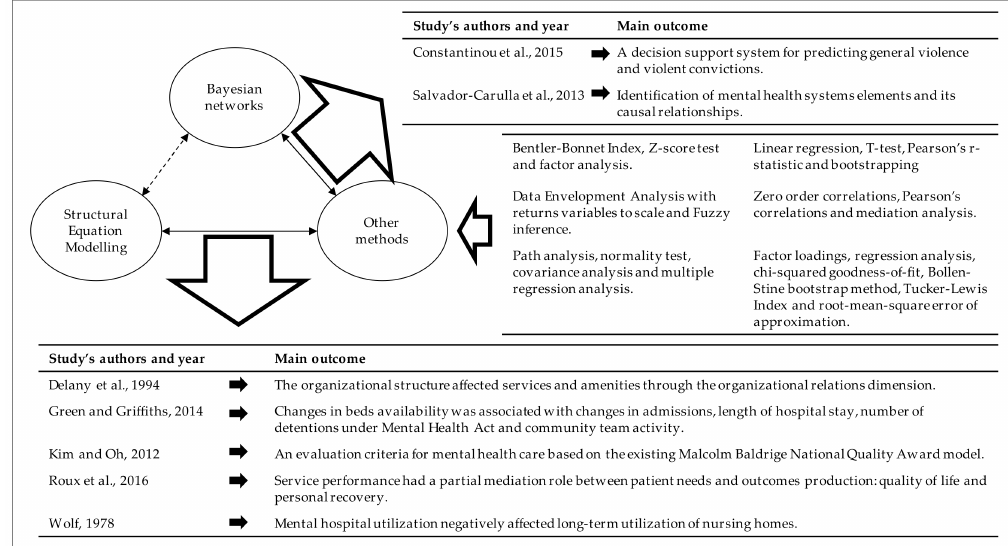
Figure 2. Formal representation of the selected studies (Note: no study combines Bayesian networks and Structural Equation